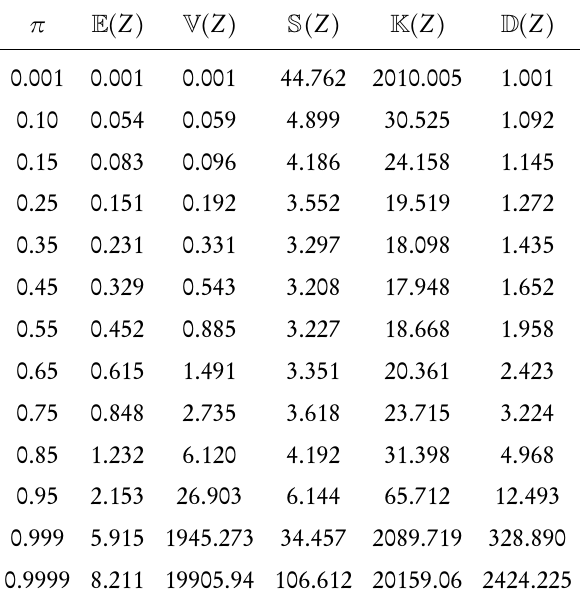
TABLE 2 (cid:69) ( Z ) , (cid:86) ( Z ) , (cid:83) ( Z ) , (cid:75) ( Z ) and (cid:68) ( Z ) of the DBH